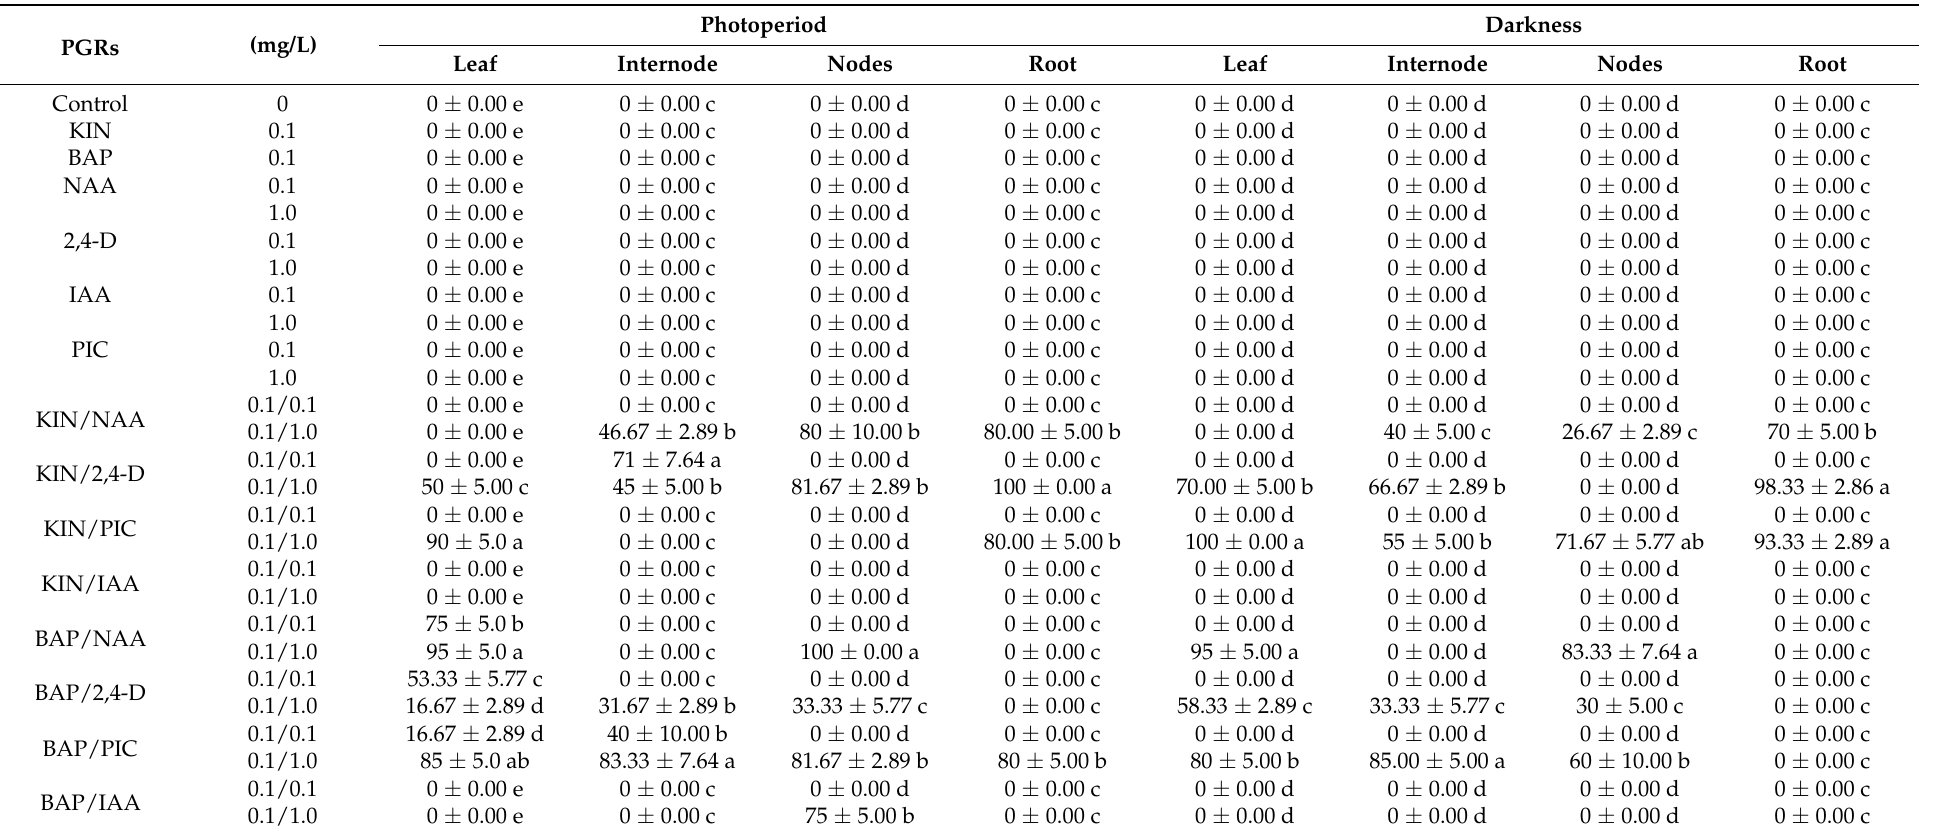
Table 1. Effect of plant growth regulators on callus induction of A. ludoviciana through different types of explants in two incubation